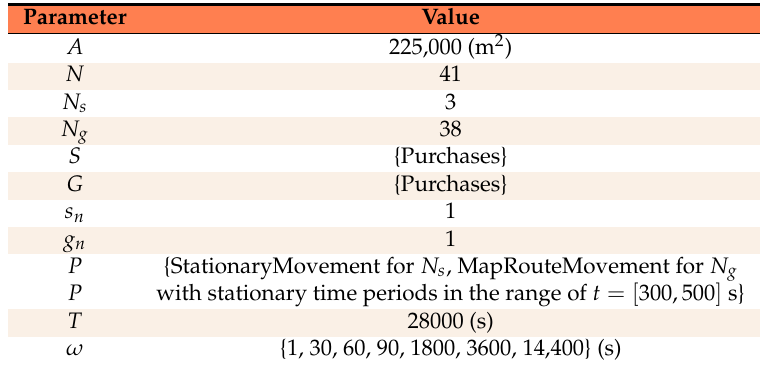
Table 2. Parameter setting for the mall